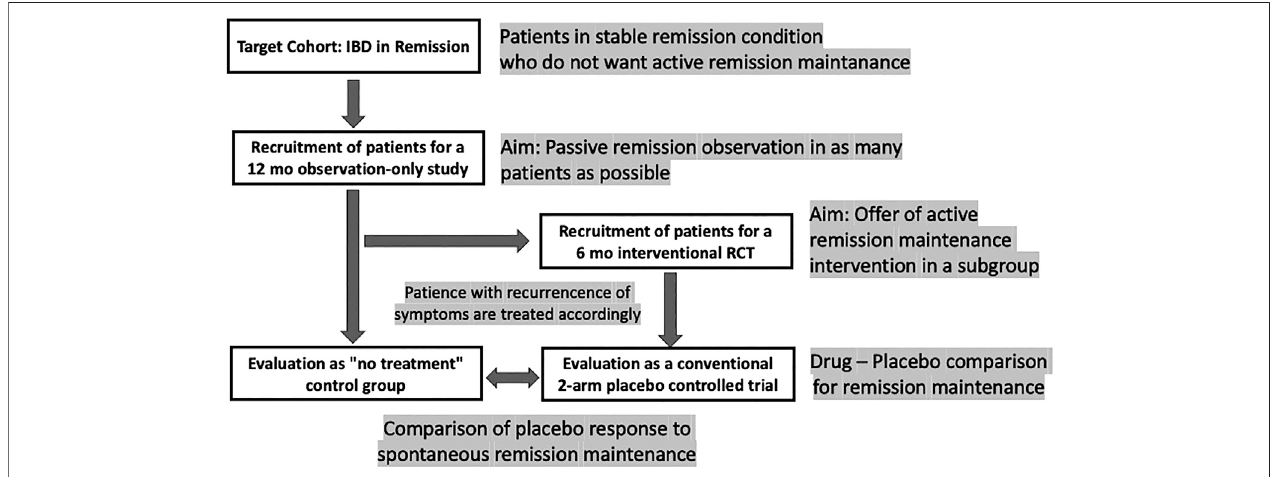
FIGURE3| DesignschemeforaremissionmaintenancestudyinIBDthatwouldallowincludinga “ no-treatment ” armtoassessthespontaneouscourseofthedisease. The concept has been called “ cohort multiple randomized and placebo-controlled trials (cmRCT) ” (Relton et al., 2010); for a discussion see (Weimer and Enck 2014).